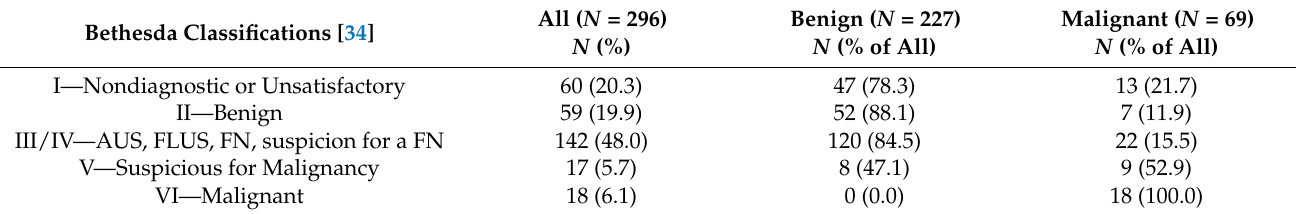
Table 1. Histopathological results of thyroid nodules (TNs) with fine-needle cytology (FNC) and surgery.